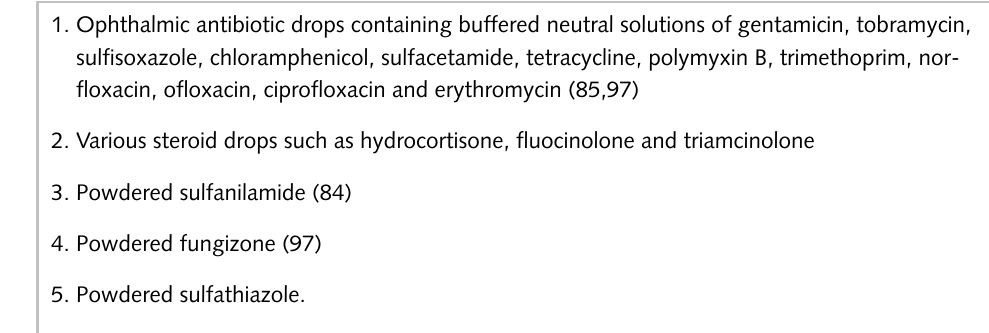
Table 8. Topical antibiotics for CSOM , as reported in the